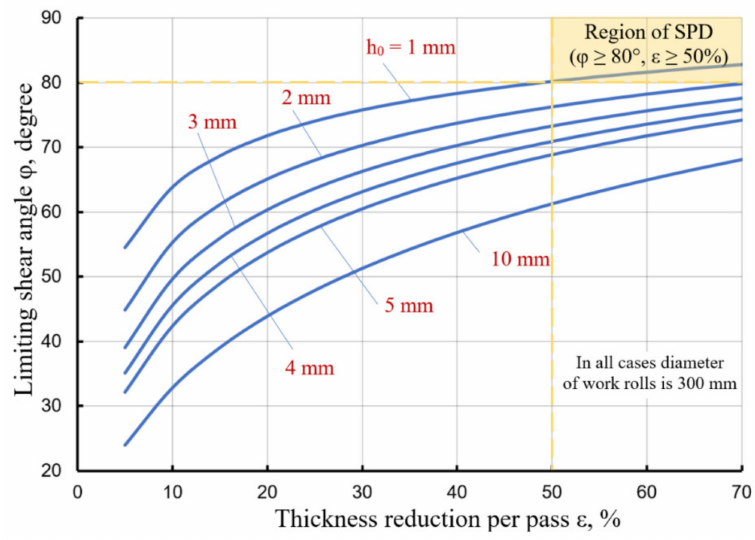
Figure 27. Influence of initial thickness h 0 of the sheet and thickness reduction per pass ε on limiting shear angle ϕ during asymmetric rolling.